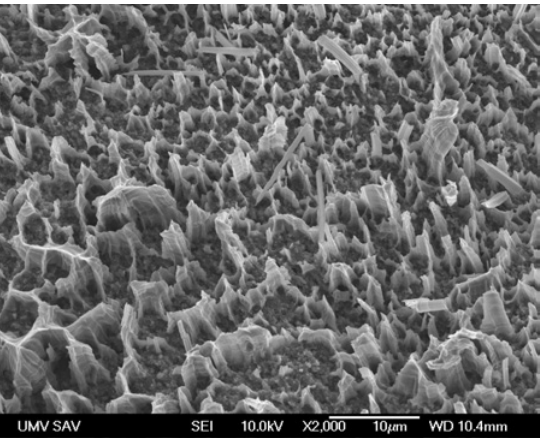
Figure 17. The fracture of Al-4 vol.% Al 4 C 3 after SP creep, direction 30°, detail of the fracture dimples of two